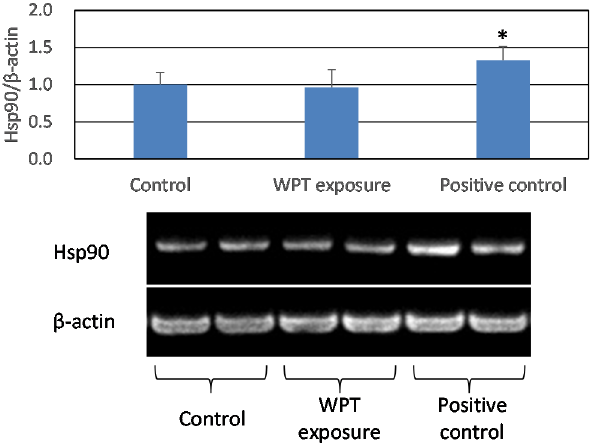
Figure 3. The expression of Hsp 90 in WI38VA13 subcloned 2RA human fibroblast cells exposed to WPT and control cells for 24 h, or heated at 43 °C as positive control. The expression of Hsp 90 was standardized to that of β -actin. Data are presented as means ± SD from three separate experiments. Photograph shows the typical results of Western blotting. * p < 0.05 compared with